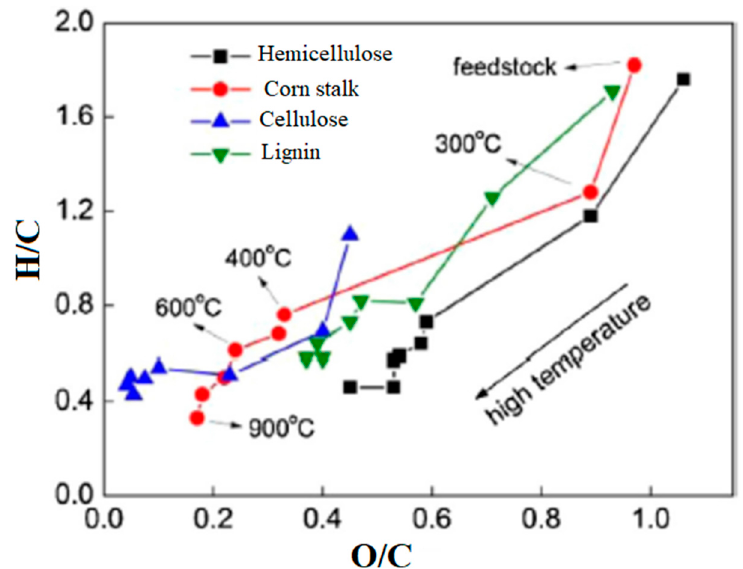
Figure 1. Van Krevelen diagram of corn stalk and corn stalk components during the thermochemical conversion process as reported by Gaojin et al. [ 50] .